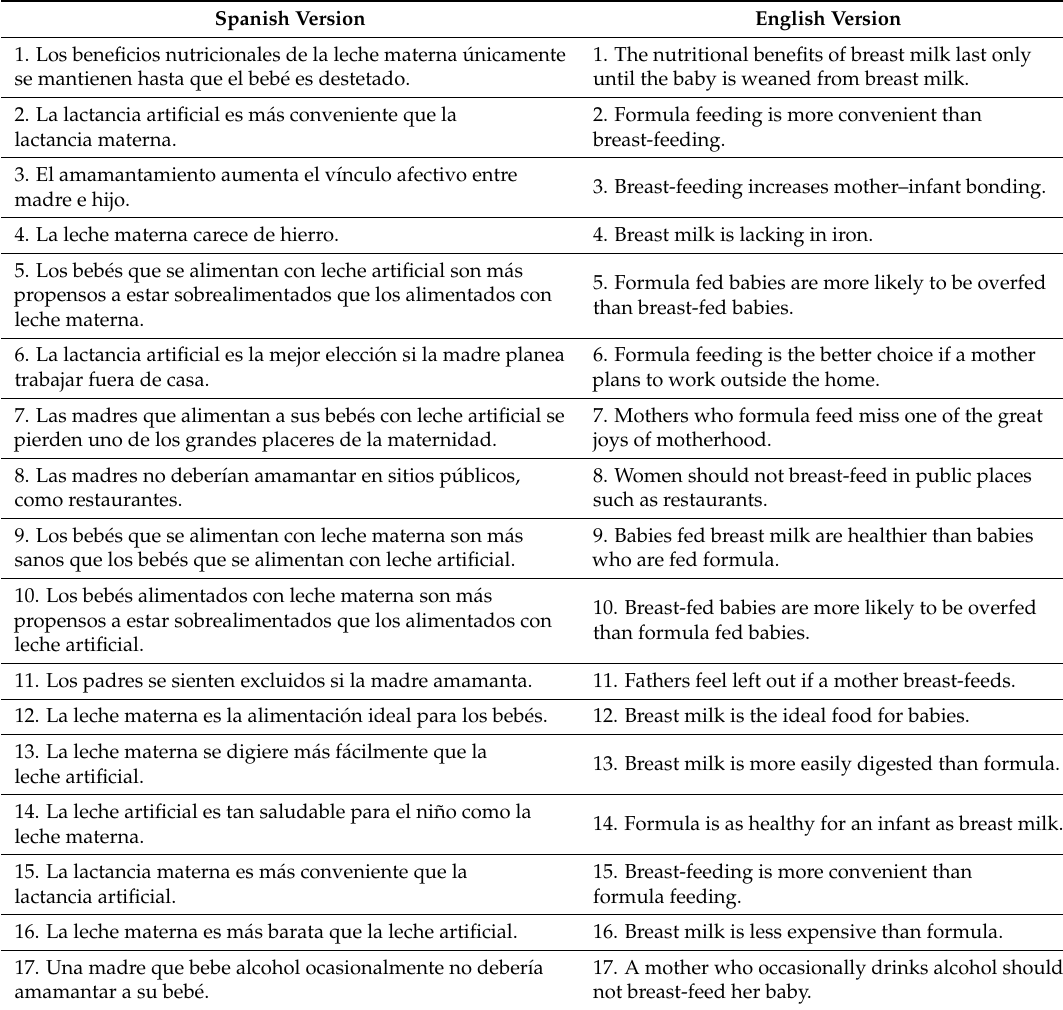
Table A1. IIFAS (Iowa Infant Feeding Attitude Scale) items. Spanish and English versions.